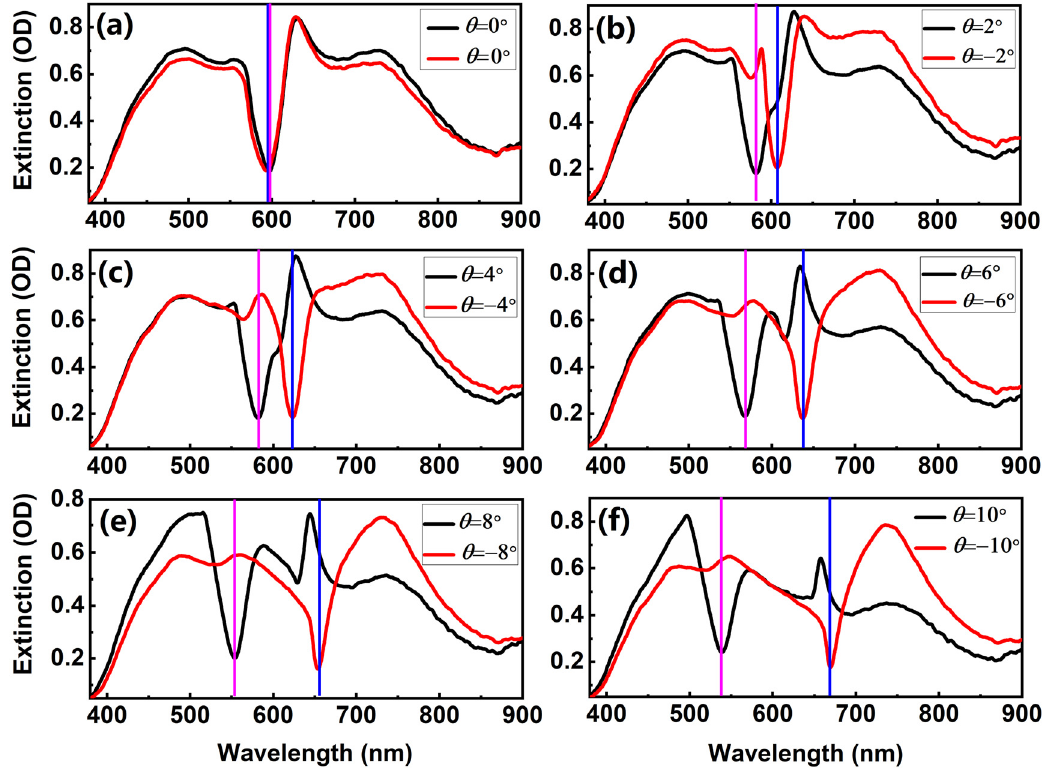
Figure 3: Experimental comparison results of optical extinction spectra of waveguide-bimetallic metagrating between two opposite